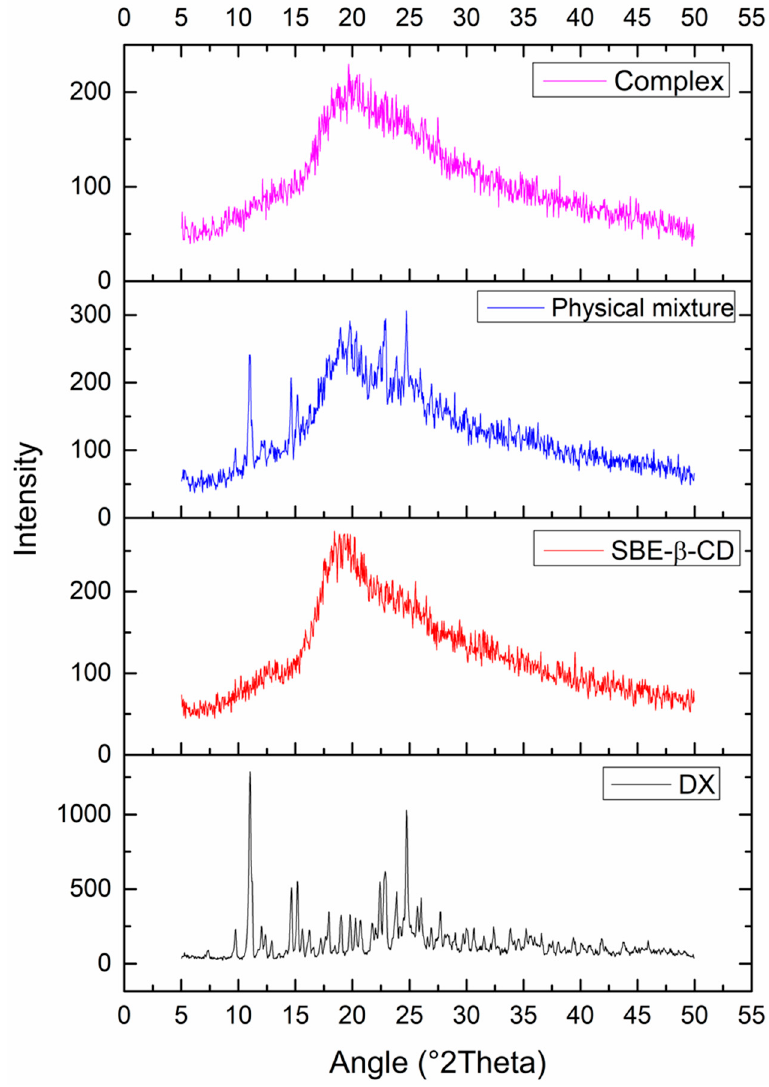
Figure 7. X-ray diffraction patterns of the DX/SBE- β -CD (1:1) complex, physical mixture (1:1), Figure 7. X-ray di ff raction pa tt erns of the DX/SBE- β -CD (1:1) complex, physical mixture (1:1), sul- sulfobutylether- β -cyclodextrin (SBE- β -CD), and doxycycline fobutylether- β -cyclodextrin (SBE- β -CD), and doxycycline (DX).